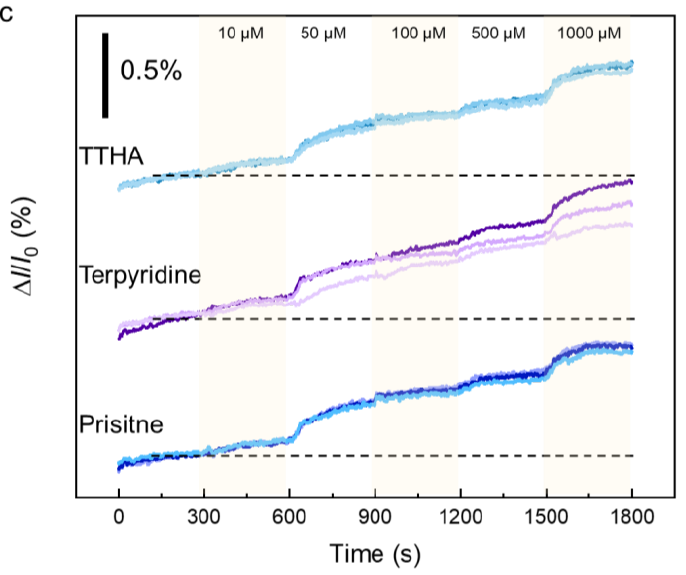
Figure 8. Responses of graphene-sensor arrays to the introduction of ( a ) cadmium chloride, ( b ) cad- mium sulfate, and ( c ) cadmium nitrate. The dashed lines represent the initial drain-current values for each.